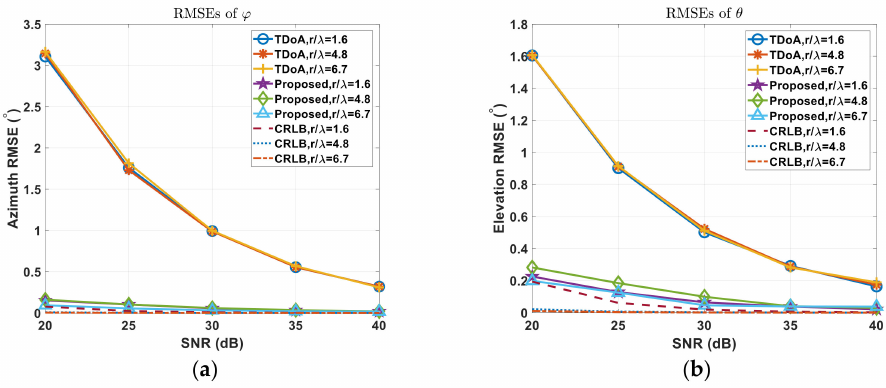
Figure 7. ( a ) RMS Errors of Azimuth angle ϕ and ( b ) RMS Errors of Elevation angle θ by TDoA only, proposed method and cramer-rao lower bound(CRLB) in different ratio r / λ